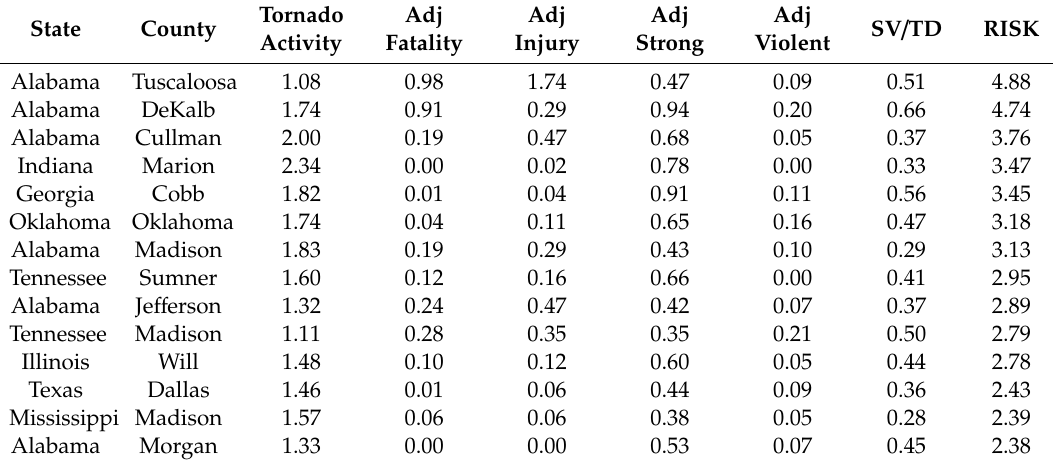
Table 2. The high risk counties. The columns represent: tornado activity, adjusted fatality, adjusted injury, adjusted strong tornadoes, adjusted violent tornadoes, and strong and violent / tornado days as described in Methods. These categories sum to create the RISK